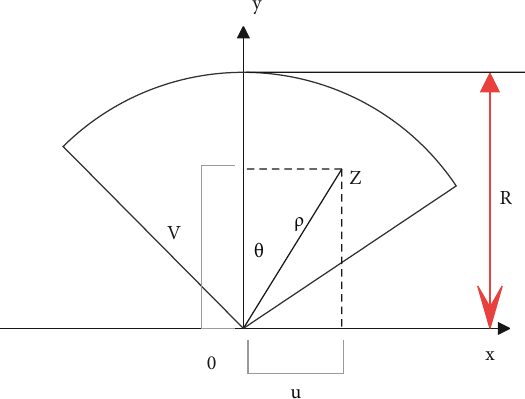
Figure 1: Cartesian-polar coordinate